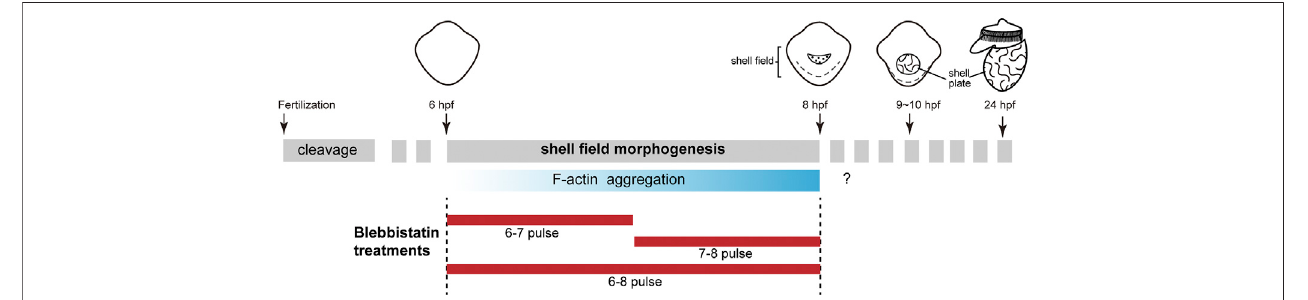
FIGURE1| F-actinaggregatesintheshell fi eldduringtheearlydevelopmentof L.goshimai .Theupperrowshowsthegeneraldevelopmentof L.goshimai ,withthe keydevelopmentaleventsofshelldevelopmentemphasized.Shell fi eldmorphogenesiscouldbemorphologicallydetectedafter6 hpfandgenerally fi nishedat8 hpf.The shellplate couldbeobservedsince 9 hpf,andthe24-hpfveligerlarvaexhibitedwell-developed shellplatecharacteristicsingastropods.Thus,theperiod from6to8 hpf should be the key stage for the morphogenesis of the shell fi eld. We found that F-actin gradually aggregated in the shell fi eld during this period (lower row). The question marks indicate that we did not determine whether F-actin aggregations were detectable in subsequent developmental stages. The design of the blebbistatin treatment experiments is shown below, which includes pulses in three time windows.